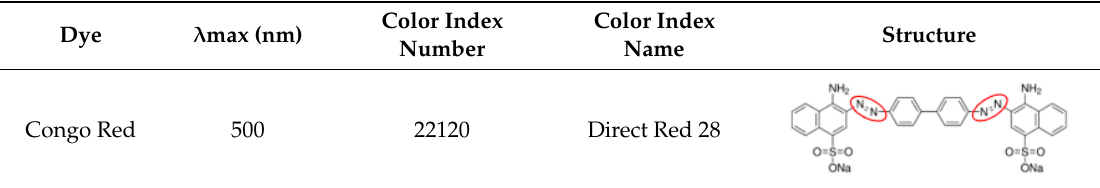
Structure Structure